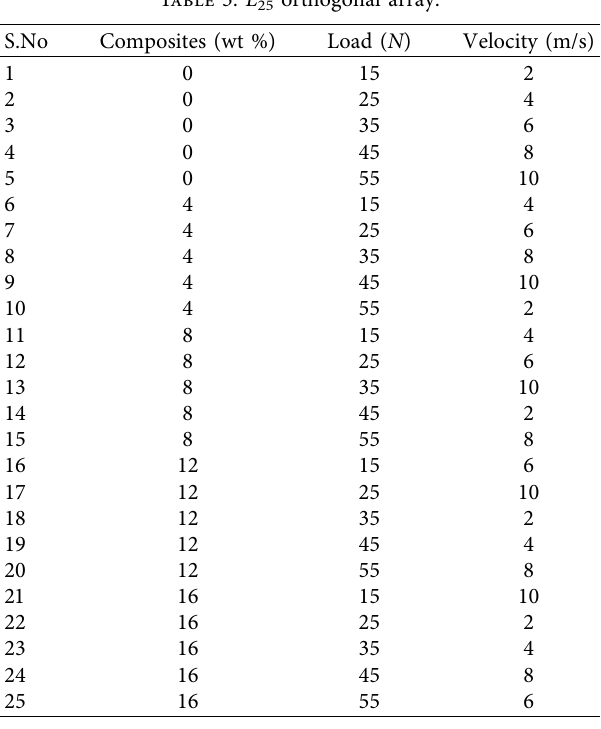
Table 3: L 25 orthogonal